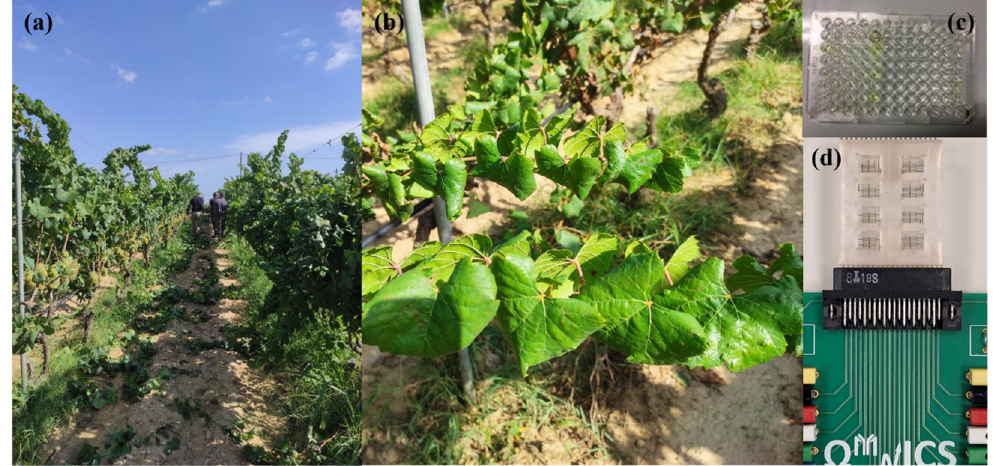
Figure 1. Grapevine leafroll disease and grapevine fanleaf disease diagnosis by ELISA and lab-on-a-chip (LOC) assays to detect Grapevine leafroll-associated virus 3 (GLRaV-3) and Grapevine fanleaf virus (GFLV). ( a , b ) Grapevines affected by GLRaV-3; ( c ) ELISA assay with diluted virus sources (1:3, 1:5, 1:10, 1:20, 1:50 and 1:100); ( d ) developed platform for portable, on-field LOC assays, with the sensor inserted in the PCB platform, ready to be connected to the potentiostat. Tests were carried on different dilutions (1:10, 1:20, 1:50, 1:100 for GLRaV-3 or 1:5, 1:10, 1:20, 1:50, 1:100 for GFLV).